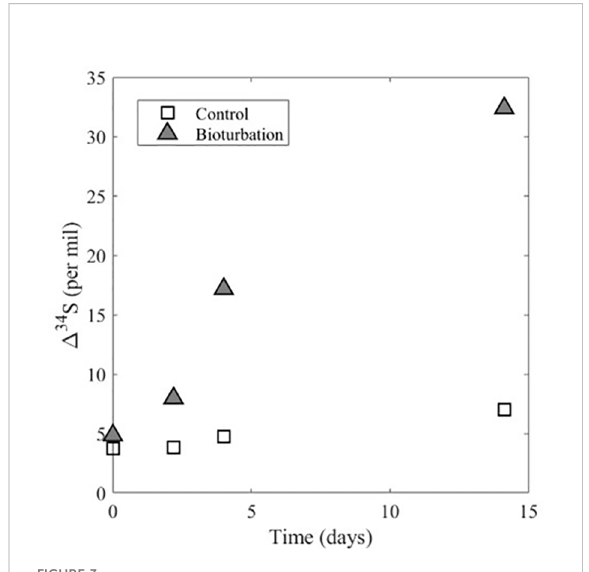
FIGURE 3 Experimental data for D 34 S SO4_sw-H2S_pw for the control experiment and the experiment with bioturbation. D 34 S SO4_sw- d 34S of sulfate in the H2S_pw represents the difference in overlying water and dissolved sul fi de in the sediment pore water. The plot shows that in both experiments D 34 S SO4_sw-H2S_pw is increasing with time, but there is a larger increase in the experiment with bioturbation.